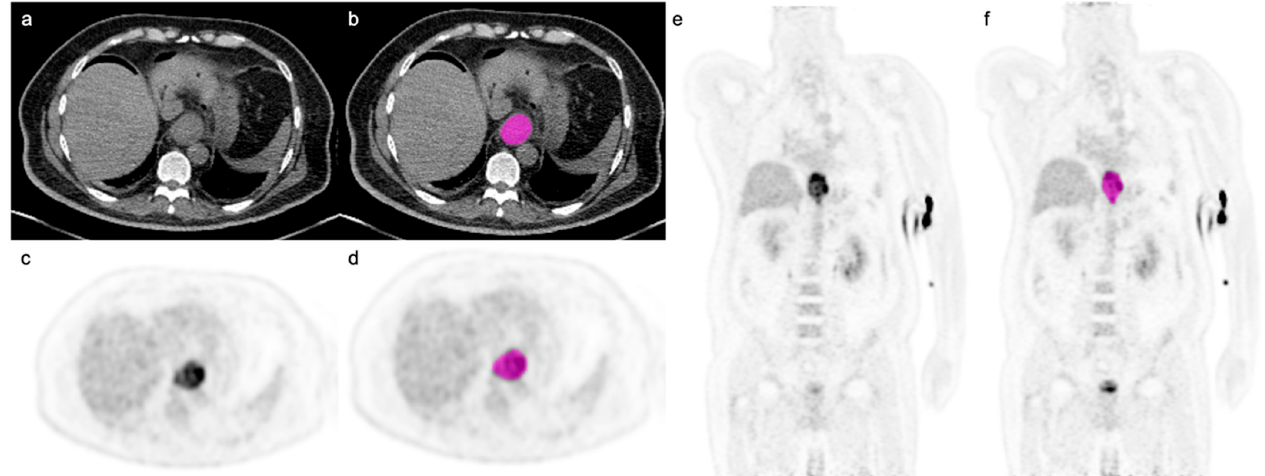
Figure 1. Axial CT image ( a ) and axial and coronal PET images ( c , e ) with segmentation (displayed in pink; ( b , d , f )) in a 60-year-old male patient with poorly differentiated gastroesophageal adenocar- cinoma (SUVmax 16.7; SUVmean 8.4). Note is made of free intraperitoneal gas in the upper abdo- men due to recent insertion of a gastrostomy